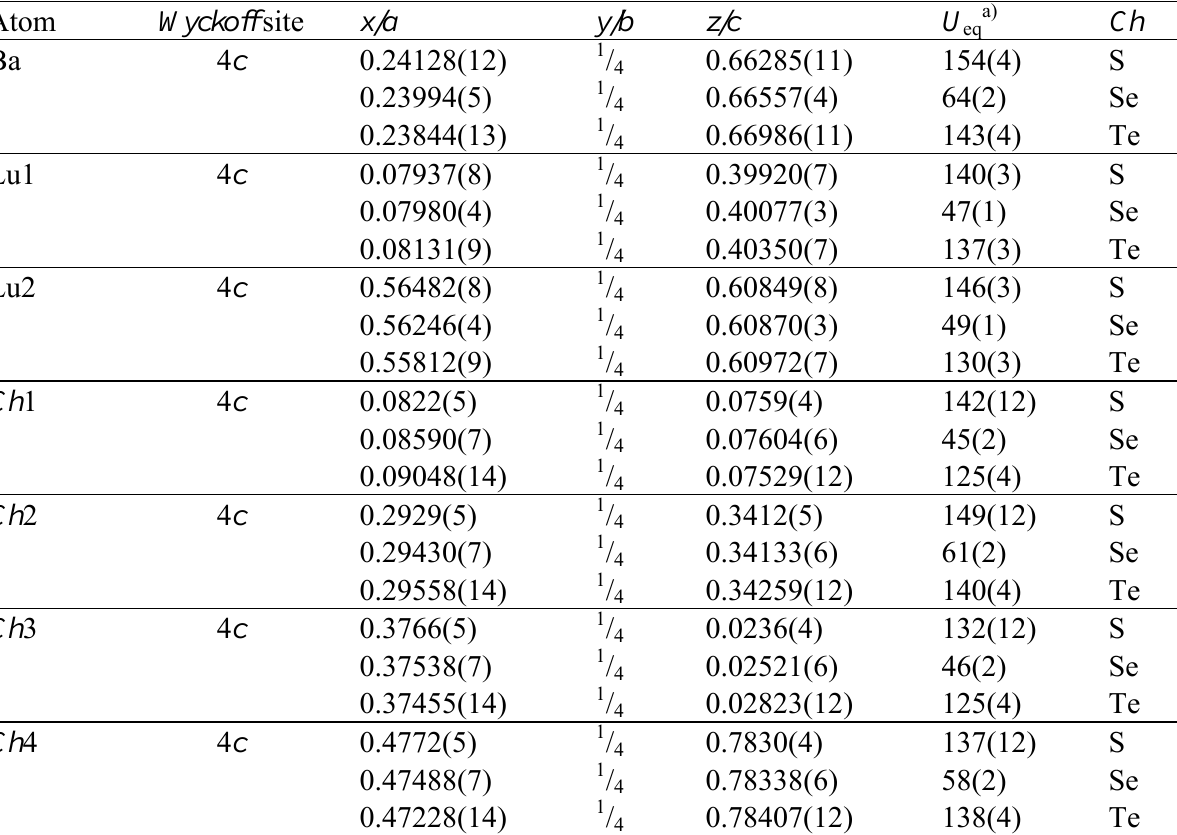
Table 1. Atomic coordinates and equivalent isotropic displacement coefficients ( U Ch representatives ( Ch = S, Se and for the three BaLu 2 4